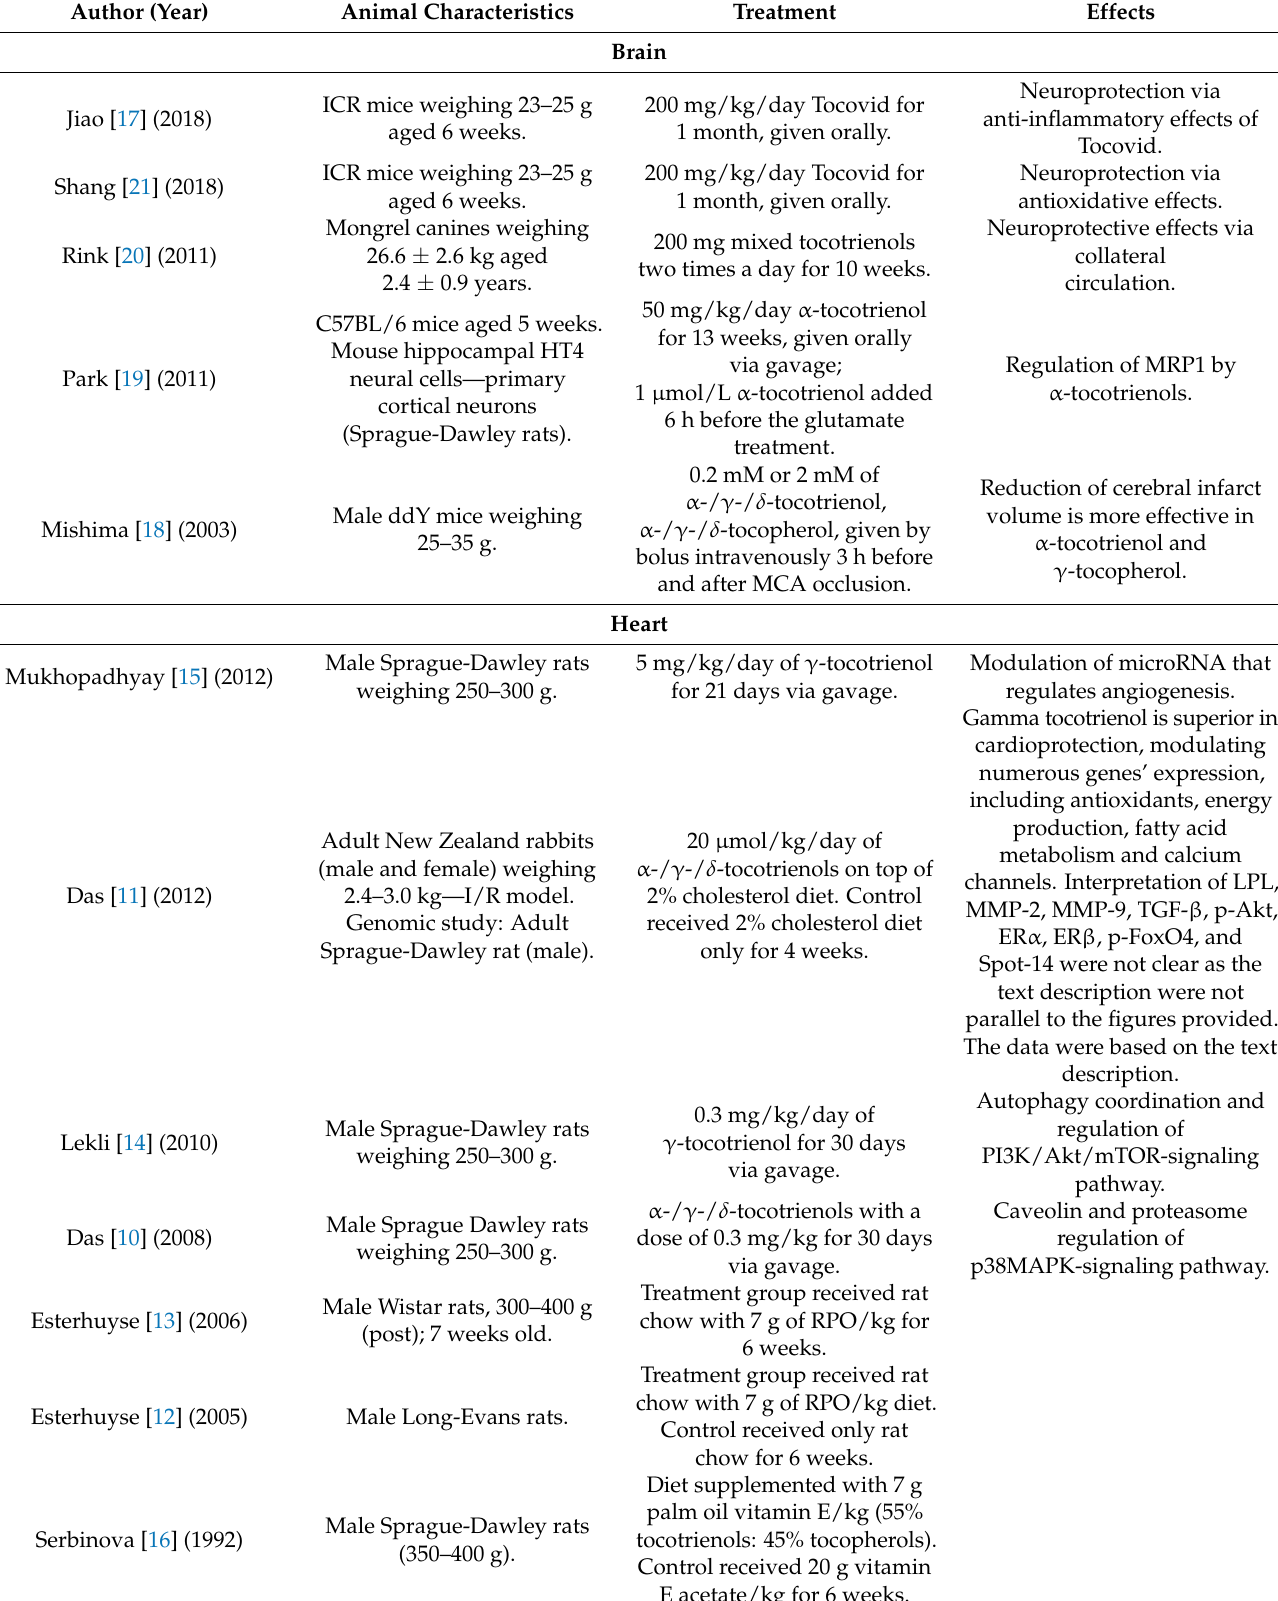
Table 1. Findings from the included